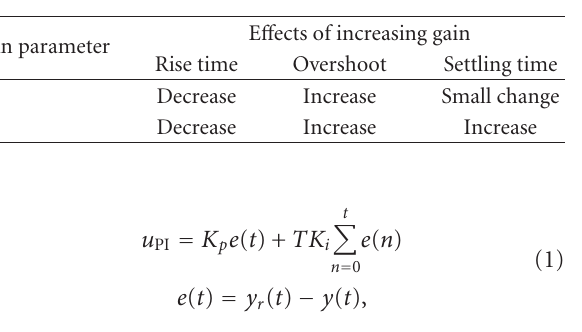
Table 1: E ff ects of the gain